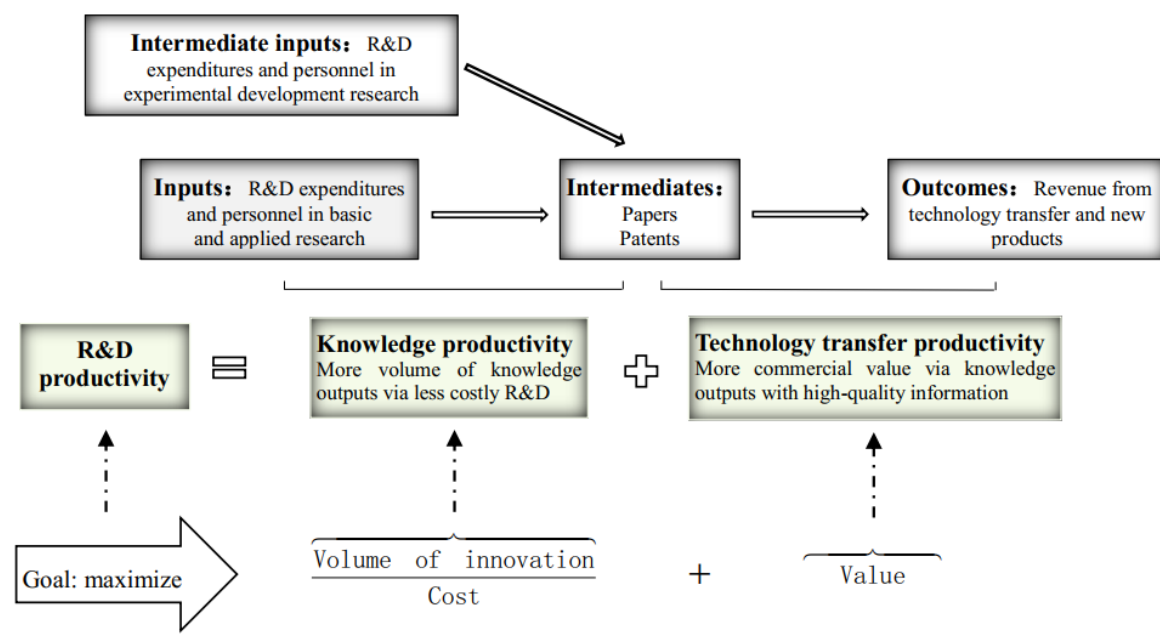
Figure 1. Multi-stage conceptual framework of R&D productivity.